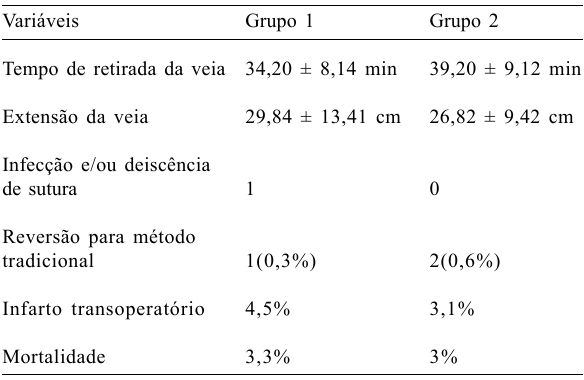
Tabela 2. Parâmetros analisados nos grupos